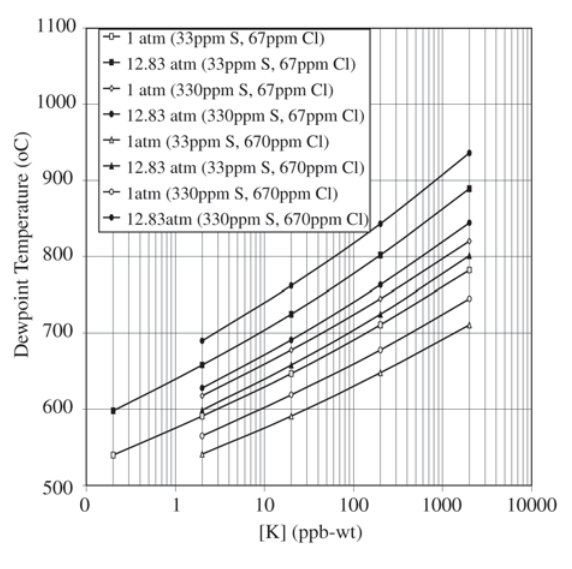
Figure 4 . Dependence of K and K levels